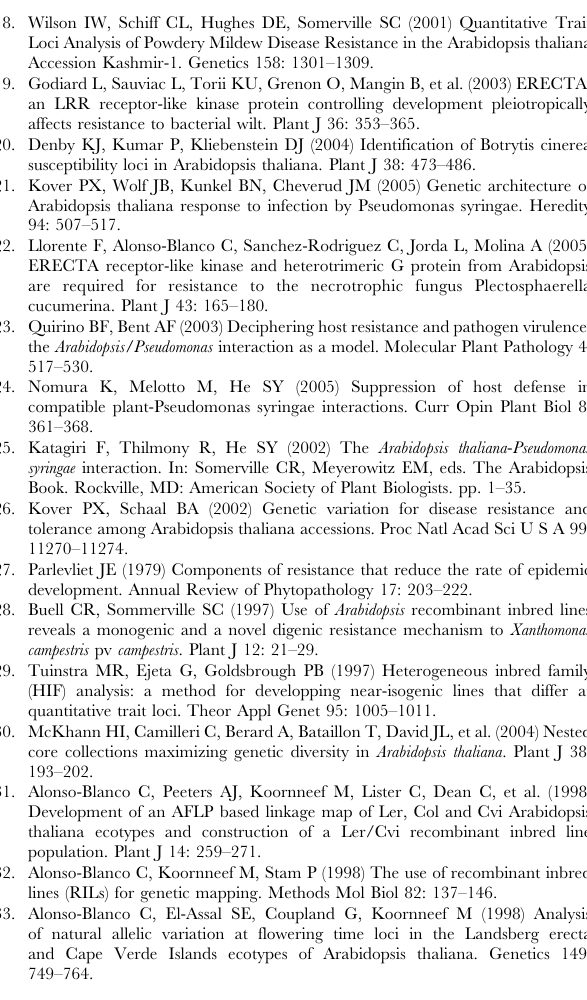
Table S1 Phenotypic correlations among